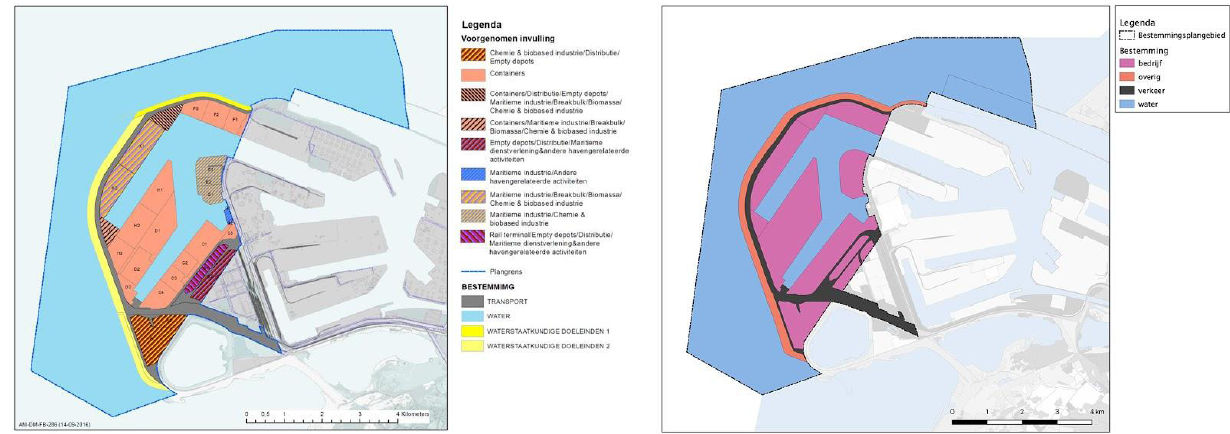
Figure 10. Zoning plans for Maasvlakte II. (a) A design for an ‘intended land use’ of Maasvlakte II established by Arcadis commissioned by the Port authority of Rotterdam, 2017 (left); ( b ) Official zoning plan/land use plan of the municipality of Rotterdam for Maasvlakte II, 2018 (right). Source: Arcadis